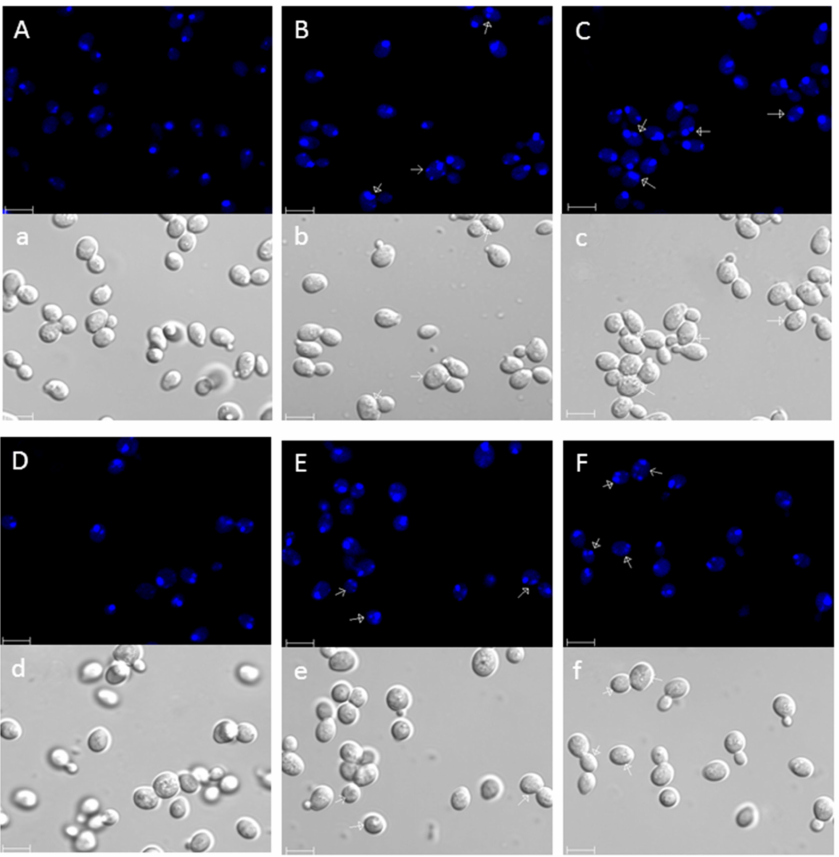
Figure 2. DAPI-stained S. cerevisiae nuclei. ( A – C ) W303 cells, ( D – F ) ∆ pep4 cells. ( A , D ) control group; ( B , C , E , F ) cells treated with 20 µ g / mL of BetA for 4 h. Arrows showed half-ring nuclear fragments and closed arrows showed randomly distributed nuclear fragments. Bar, ( a – f , A – F ), 5 µ m. Meanwhile, Annexin V / propidium iodide (PI) co-staining was used to quantify externalization of phosphatidylserine, an early apoptotic event (Annexin V positive), and membrane permeabilization, which is indicative of necrotic death (Annexin V negative, PI positive). Cells exposed to BetA were frequently stained green at the cell periphery after digestion of cell wall, whereas a few cells in more advanced apoptotic or necrotic stages stained green and red due to the inability of cell membrane to exclude PI (Figure 3A). Flow cytometry results showed that about 13.24% of the ∆ pep4 cells were Annexin V positive or both Annexin V and propidium iodide positive after the treatment by BetA, but only 7.15% showed the same result for wild-type cells. DMSO groups revealed fewer apoptotic cells in contrast to the BetA-treated groups, respectively (Figure 3B). Meantime, these four groups all showed a low necrotic rate (Figure